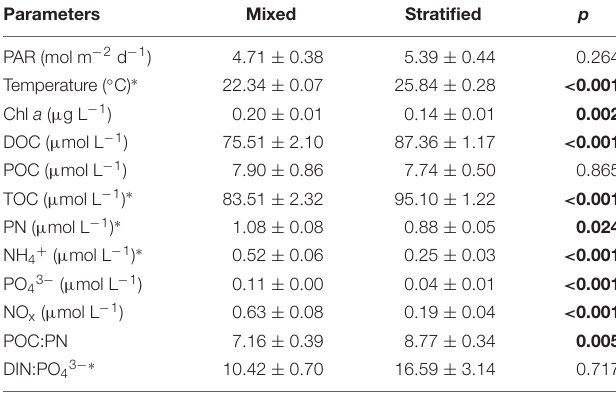
TABLE 1 | Environmental water parameters in the mixed and stratified periods.